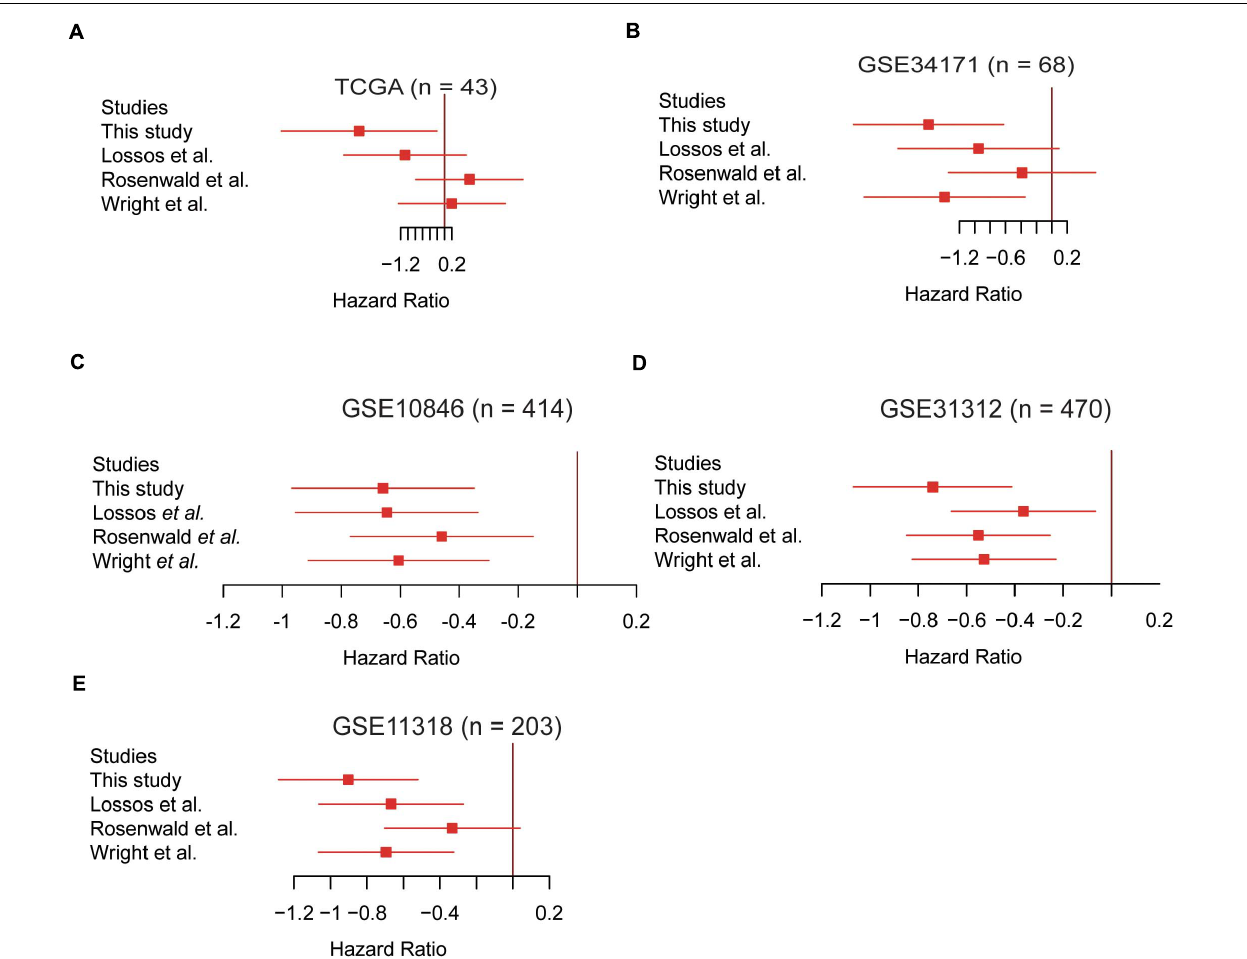
FIGURE 4 | The Cox model based on the five gene signatures was superior to other models. The performance of the four prognostic models in the validation datasets of TCGA ( n = 43), GSE34171 ( n = 68), GSE10846 ( n = 414), GSE31312 ( n = 470), and GSE11318 ( n = 203) are displayed in panels (A–E) . The log2-hazard ratios and 95% confidence intervals were denoted by the red boxes and